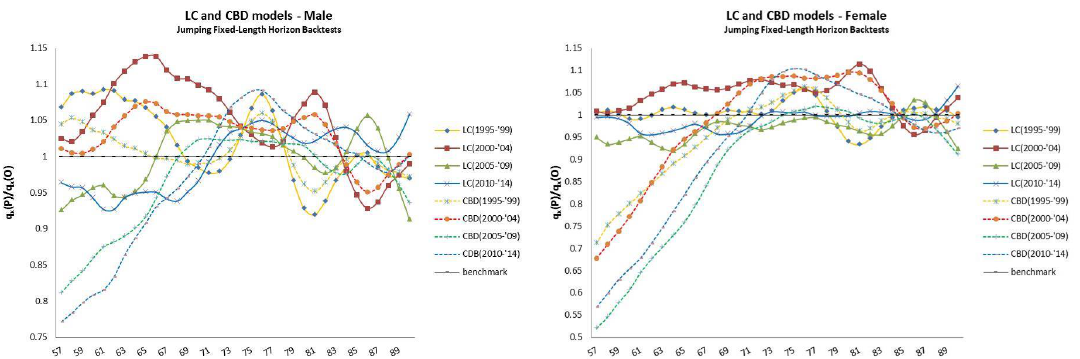
P x , t ratio: comparison between models on the same gender. Note: the curves q O x , t q P x , t ratio over the five-years forecast q O x , t